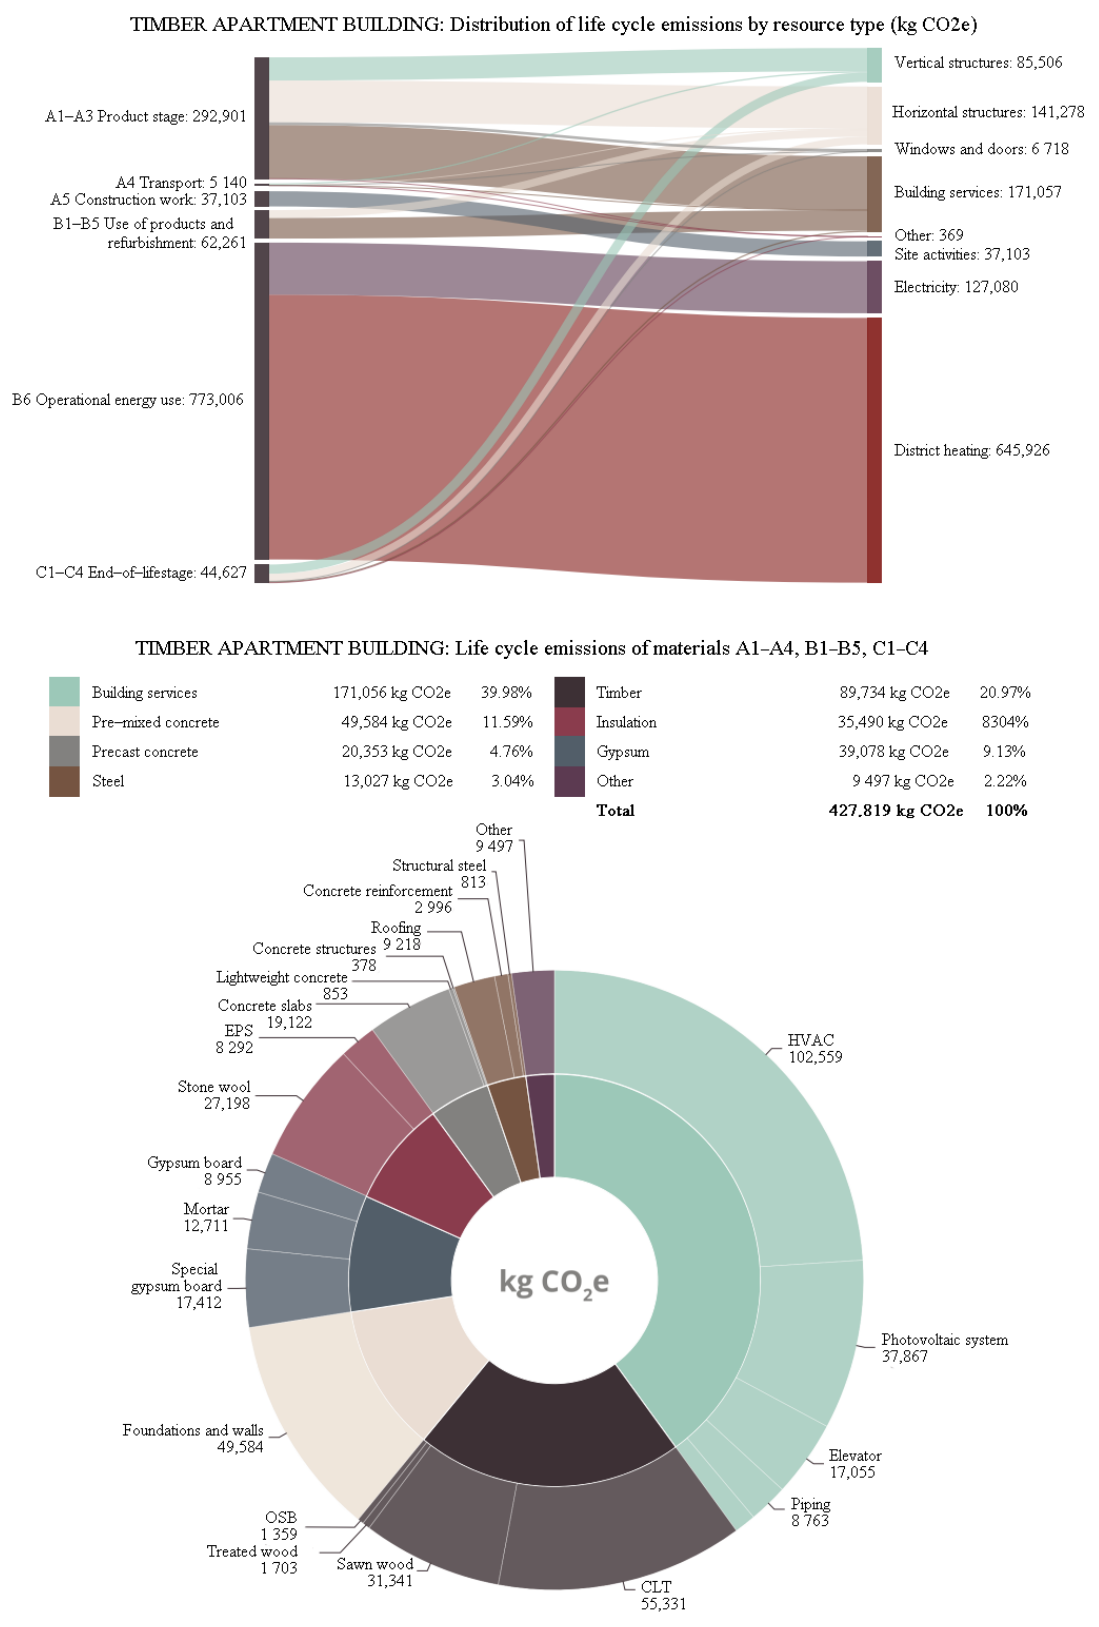
Figure 15. Distribution of the carbon footprint of the timber apartment building.